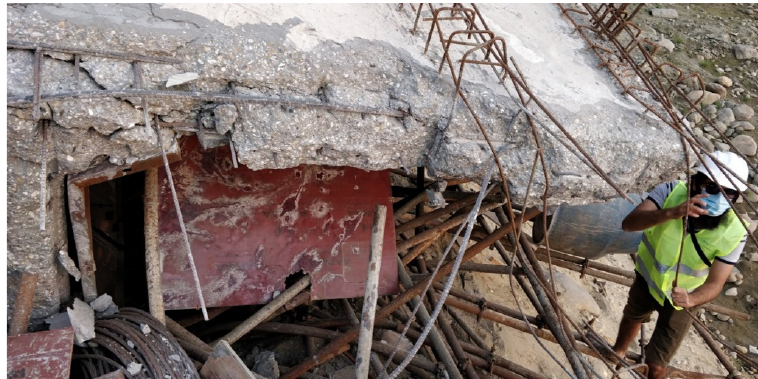
Infrastructures 2022 , 7 , x FOR PEER REVIEW Figure 12. Pulled-out holes in slab in the fractured location. Figure 12. Pulled-out holes in slab in the fractured location.